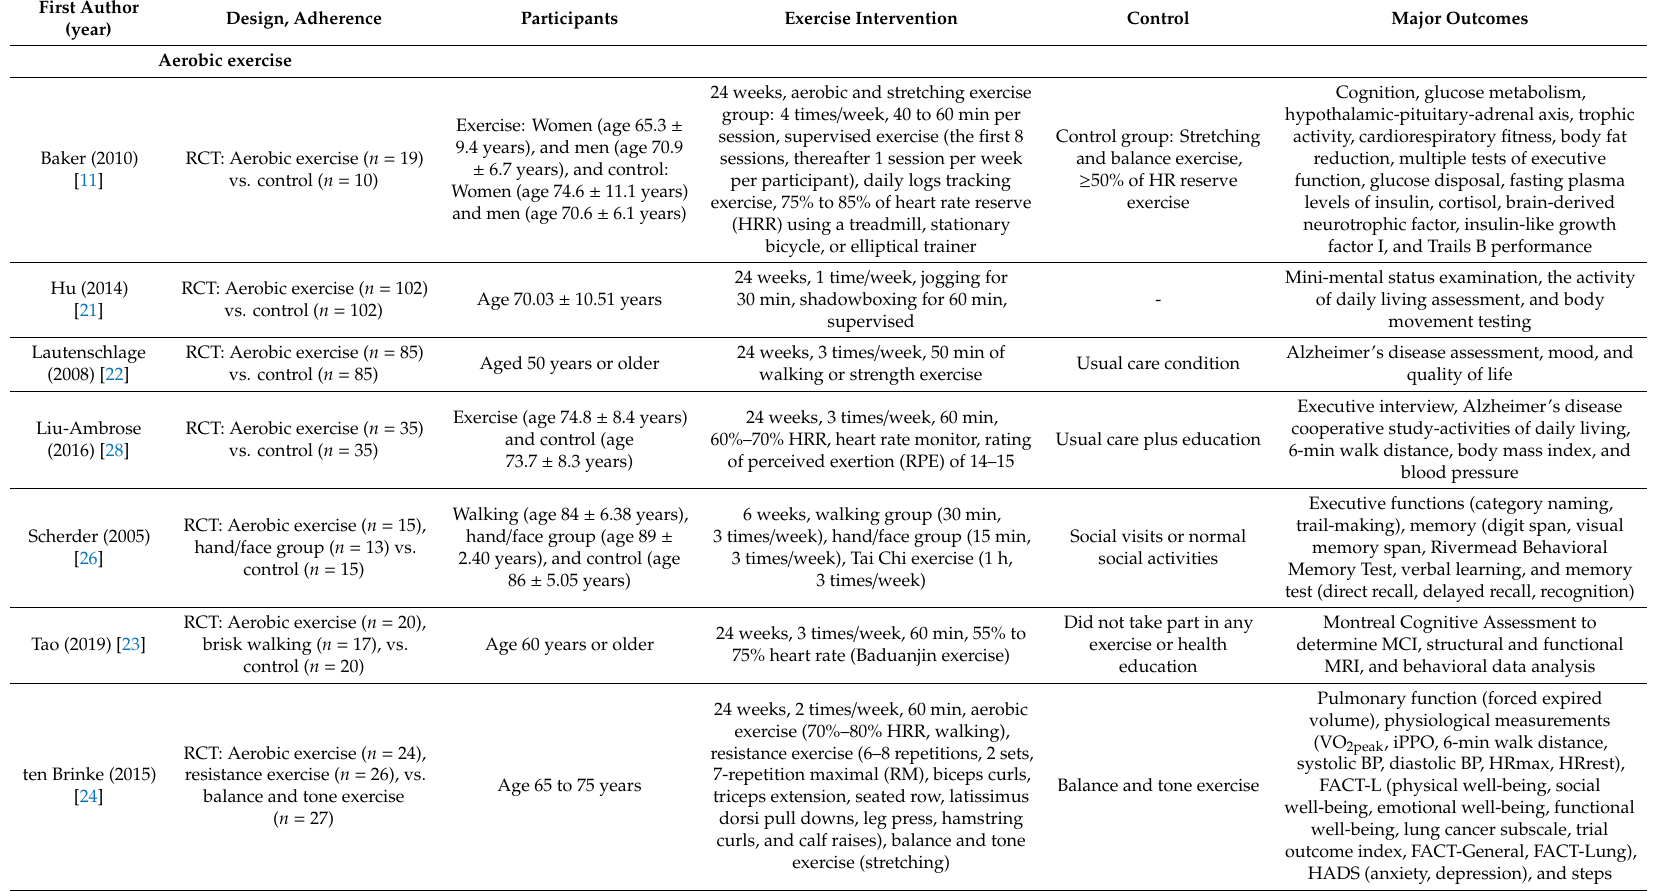
Table 1. Exercise intervention characteristics of selected